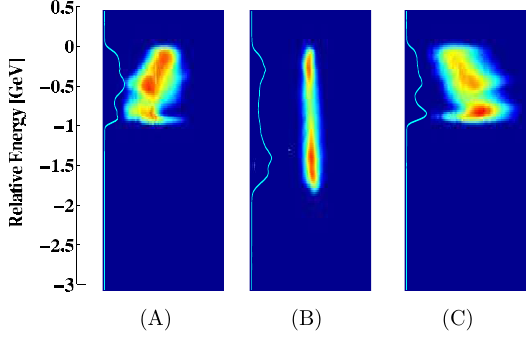
FIG. 3. (Color) All images show the energy spectrum of the electron beam at the Cherenkov radiator. The scale on the left indicates the relative energy along the vertical component, where zero is defined to be the highest energy without plasma. The images are plotted with a logarithmic color map in order to bring out the tails. The vertical profile is superimposed along the left edge of the image. The three events are taken over a period of several minutes. (A) The beam’s waist located 45 cm upstream of the plasma entrance and no ionization has occurred in the Li vapor. (B) The waist at the plasma entrance and ionization of the Li vapor. (C) The waist located 55 cm downstream of the plasma entrance and again no ionization of the Li vapor.